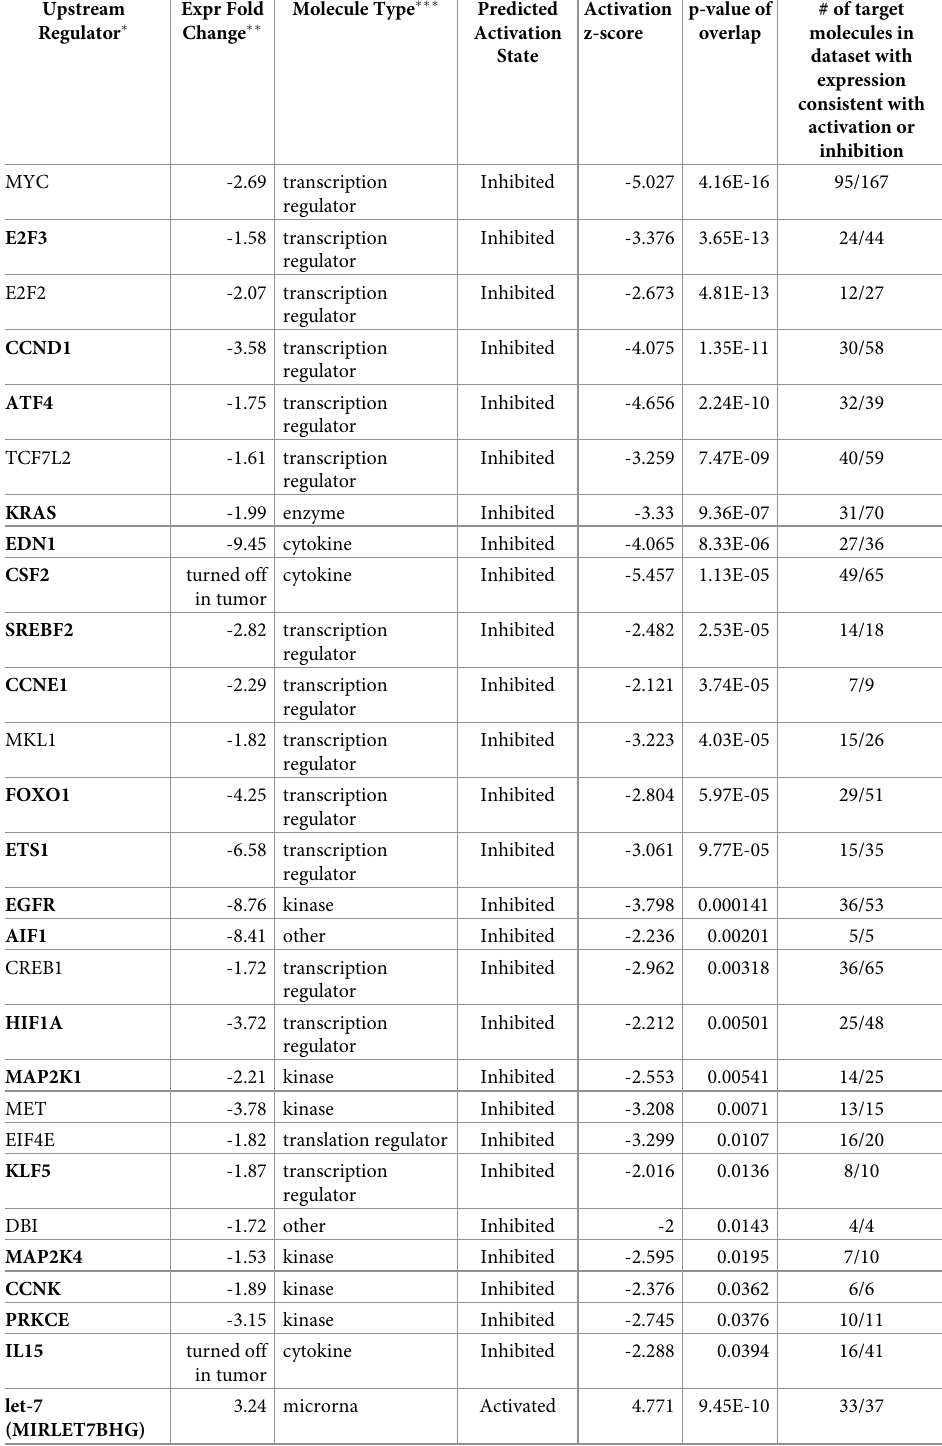
Table 3. Upstream regulators predicted for AGS tumor vs AGS cell